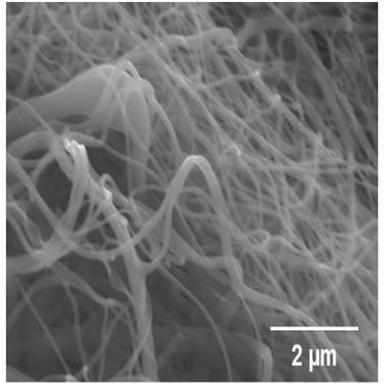
SEM micrographs (SE-mode) of the 3Y–Zr fibers sintered at 700 °C with